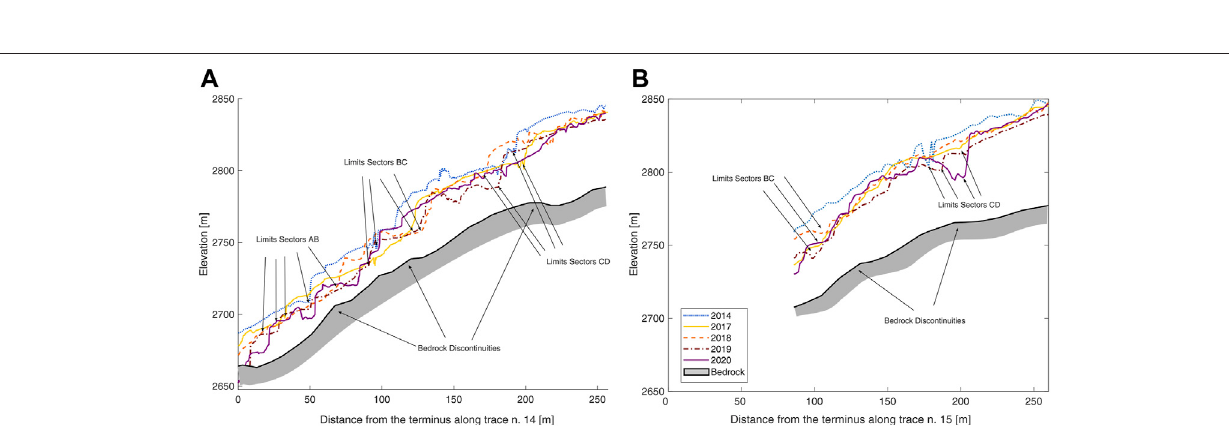
Frontiers in Earth Science |